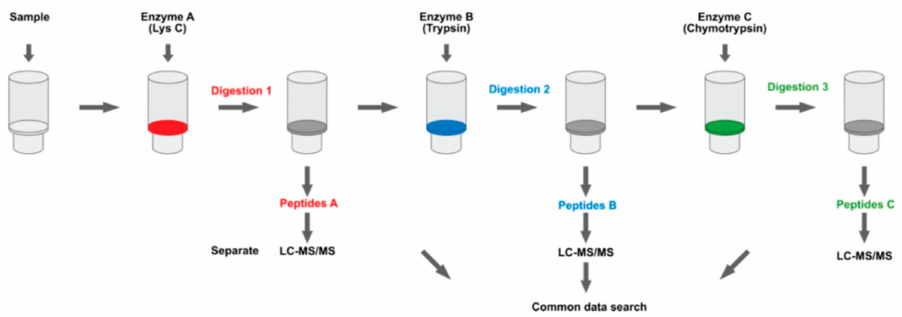
Figure 4. The schematic workflow for multi-enzyme digestion filter-aided sample preparation. This figure was adopted from Ref.